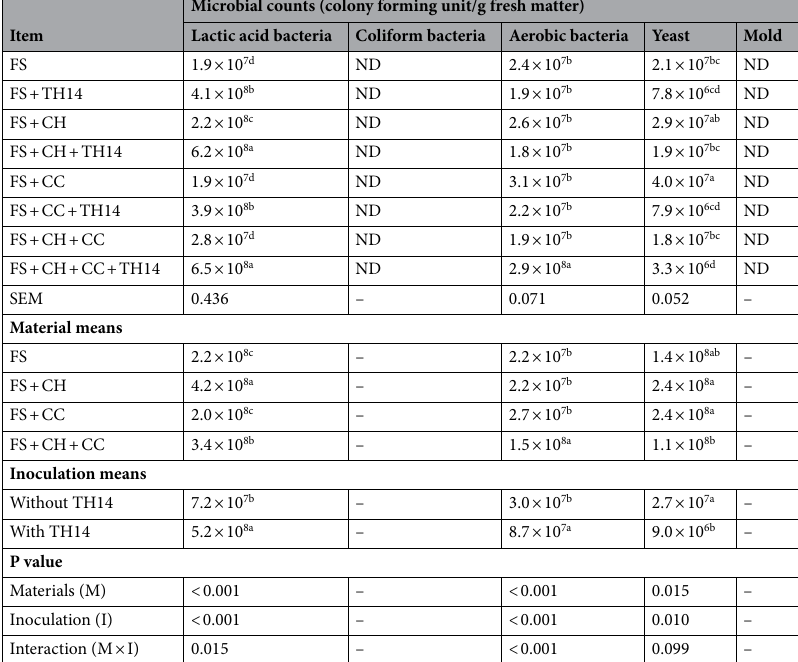
Table 3. Microbial counts of the FS mixture silages. FS forage sorghum, CH Cavalcade hay, CC cassava chip, TH14 L. casei TH14 inoculant, SEM standard error of the means, ND not detected. Means within columns with difference superscript letters differ at p <